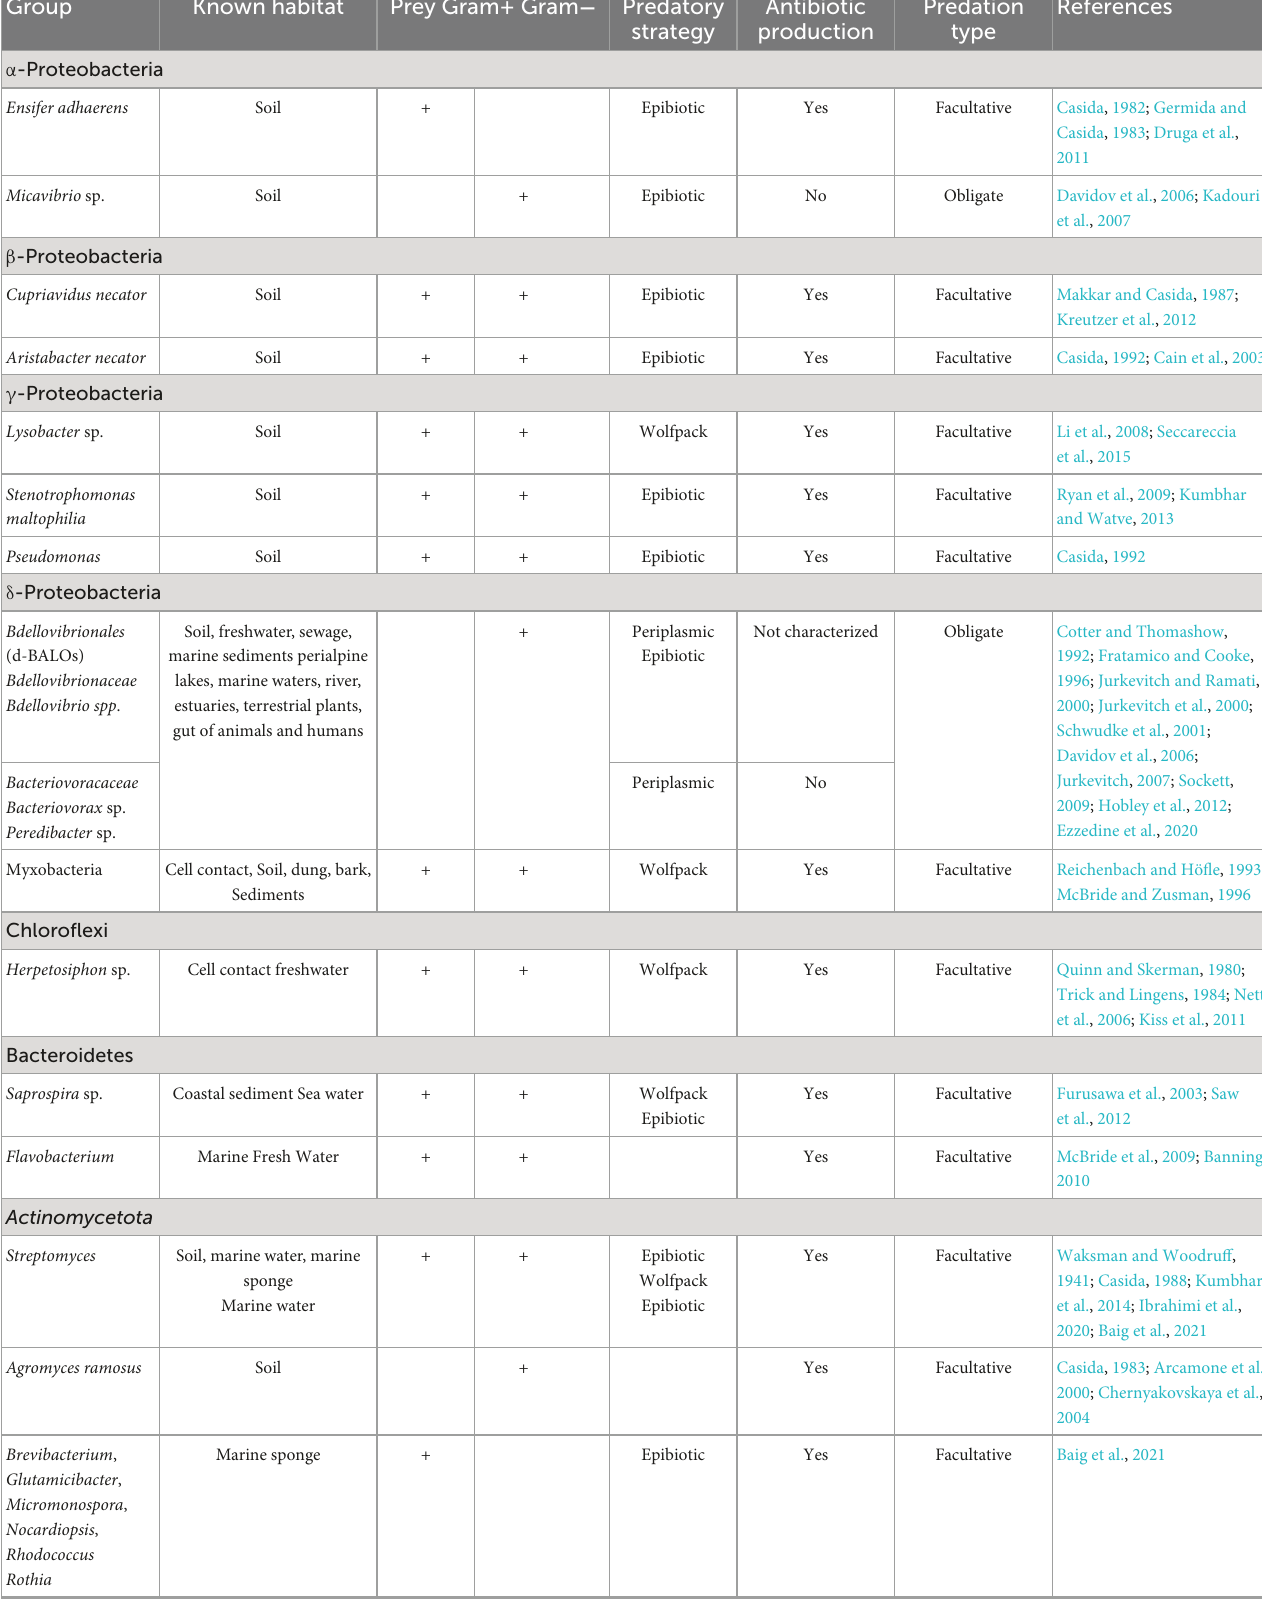
TABLE 1 Predatory bacteria and their biological